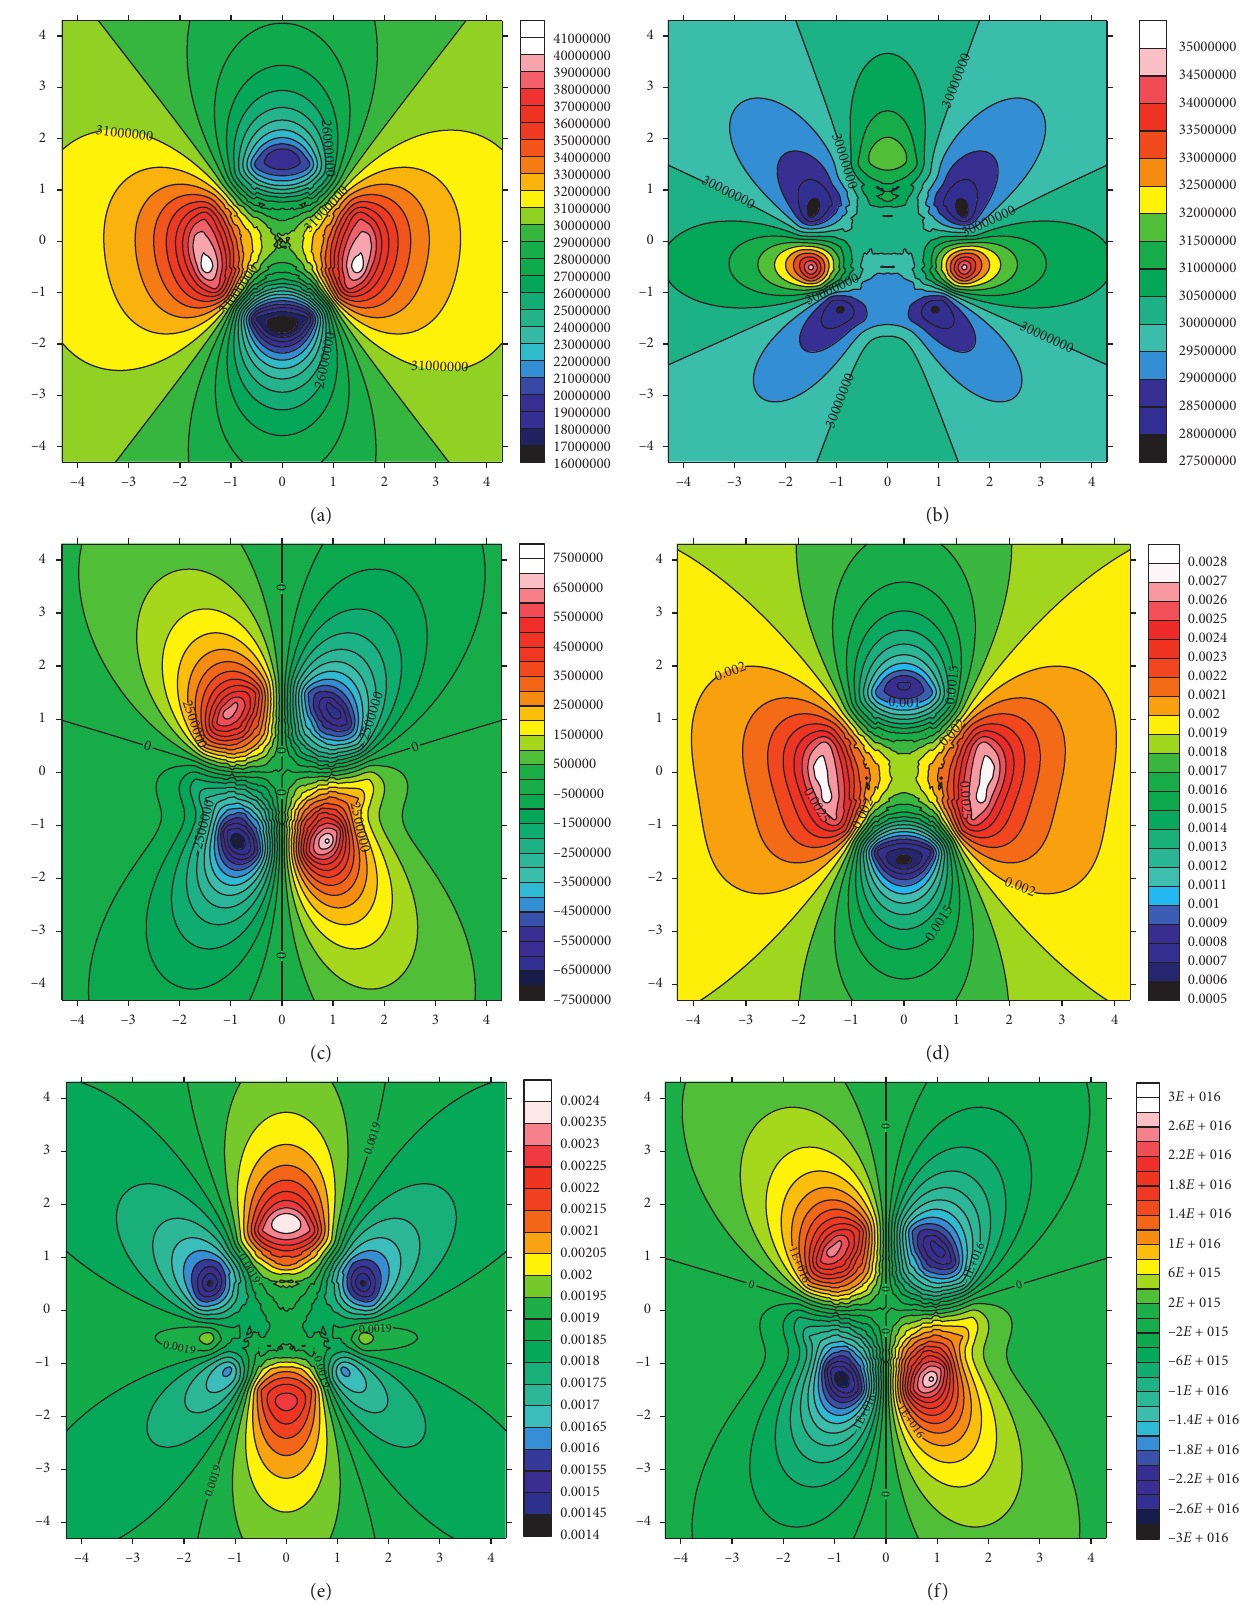
Figure 1: Contour maps of horseshoe-shaped tunnel’s strain and stress. (a) Surfer contour map of σ (c) Surfer contour map of τ ρθ . (d) Surfer contour map of ϵ ρ . (e) Surfer contour map of ε θ . (f) Surfer contour map of σ ρθ